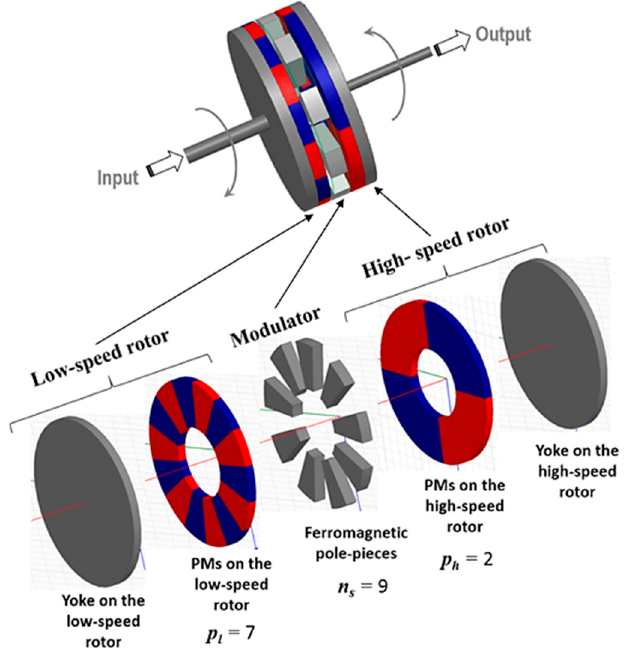
Figure 1. Topology of the AFMG.